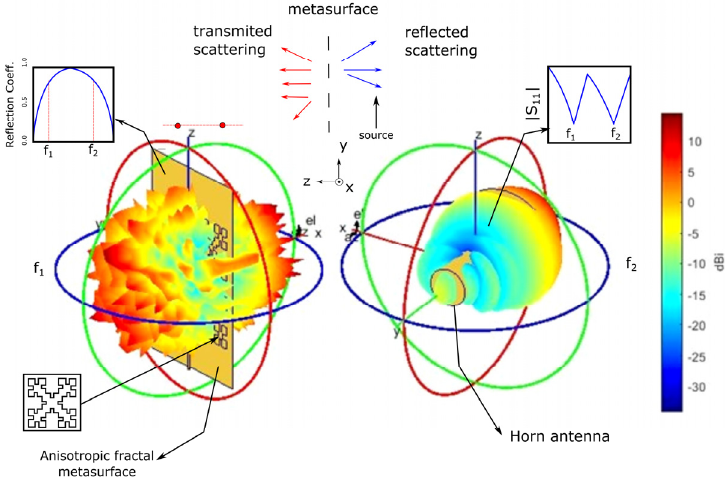
Figure 22. Direct comparison between Minkowski fractal antenna and Horn